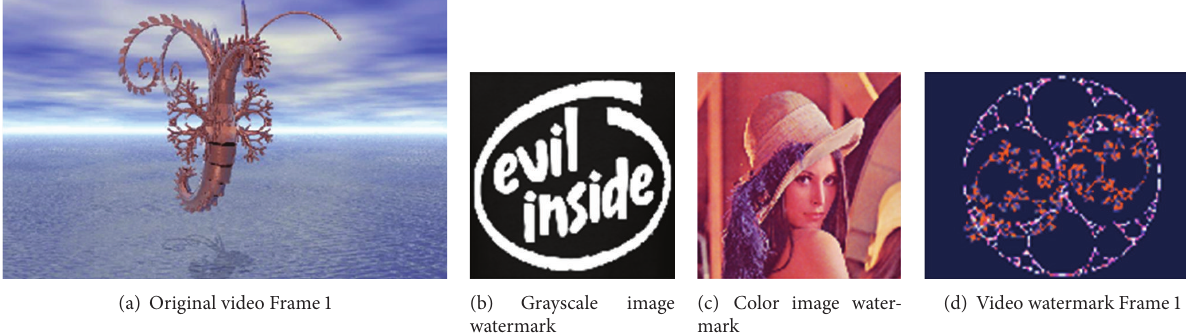
Figure 6: Host video and watermarks.